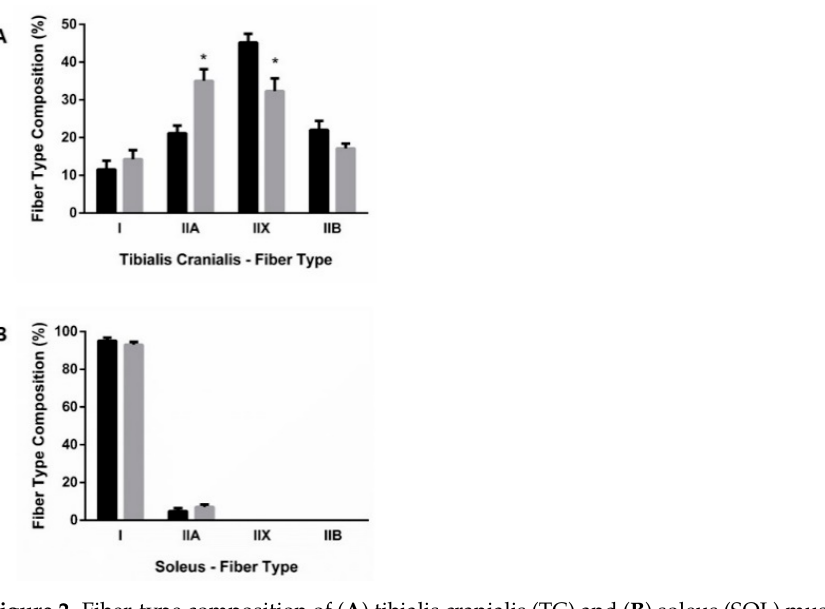
Figure 2. Fiber-type composition of ( A ) tibialis cranialis (TC) and ( B ) soleus (SOL) muscles. Student’s t-test between control (black bars) and energy-restricted (grey bars) groups. * p < 0.05 vs. control.